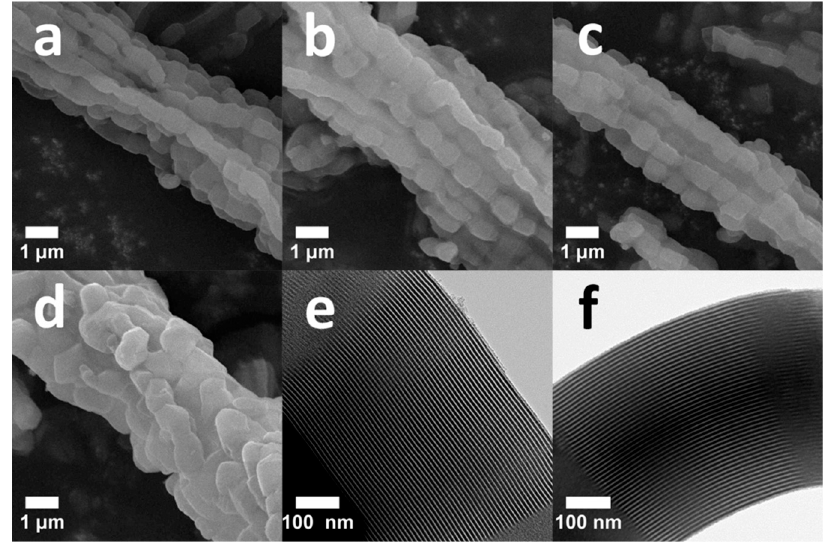
Figure 4. Scanning electron microscopy (SEM) images of SBA-15 ( a ), S-N 1 -HPW ( b ), S-N 2 -HPW ( c ), and S-N 3 -HPW ( d ); transmission electron microscopy (TEM) images of SBA-15 ( e ) and S-N 2 -HPW ( f ). Table 2. Weight ratios of Si/W in S-N x -HPW and S-HPW materials measured by SEM equipped with energy dispersive X-ray spectroscopy (SEM-EDX) at three randomly selected regions. Materials Weight Ratios of Si/W Region 1 Region